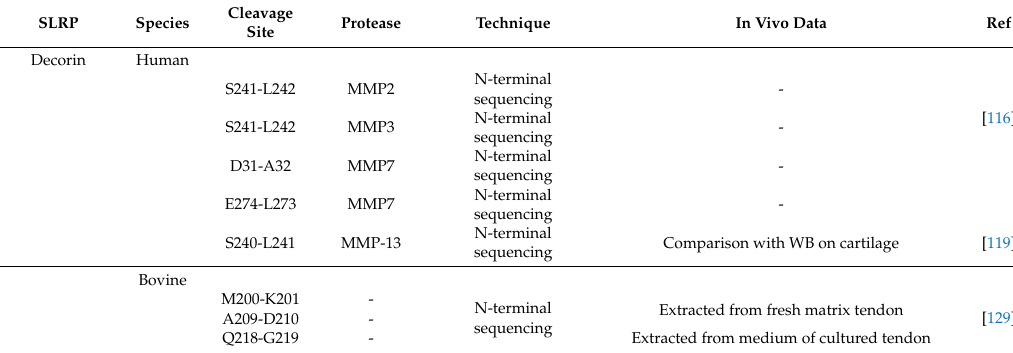
Table 3. Specific cleavage sites among the SLRP family in the skeletal